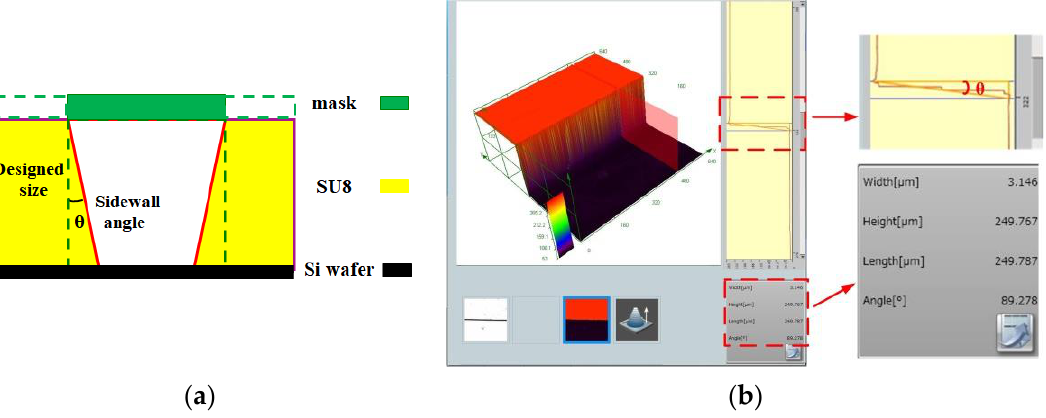
Figure 6. ( a ) Sidewall profile of the fabricated filter and ( b ) h = 249.7 μm, θ = 0.72° (i.e., 90 – 89.278°).